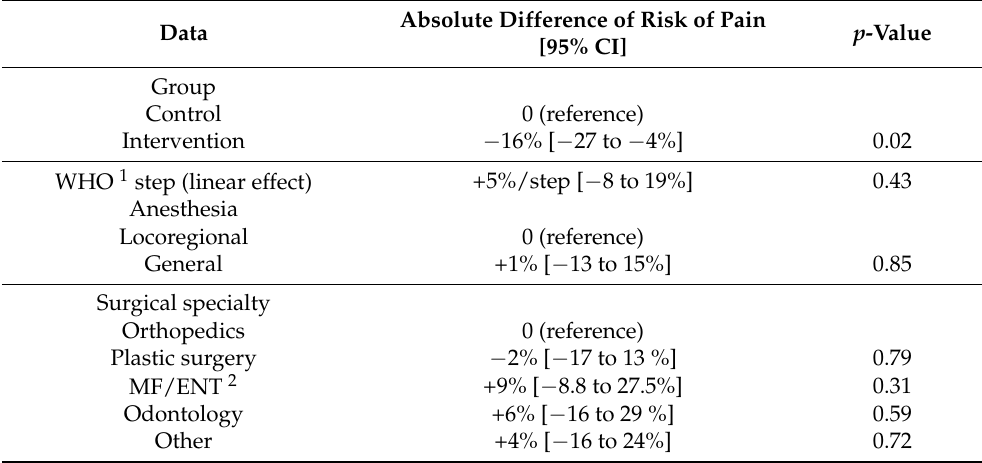
Table 2. Multivariable general linear model explaining the risk of pain intensity >3.